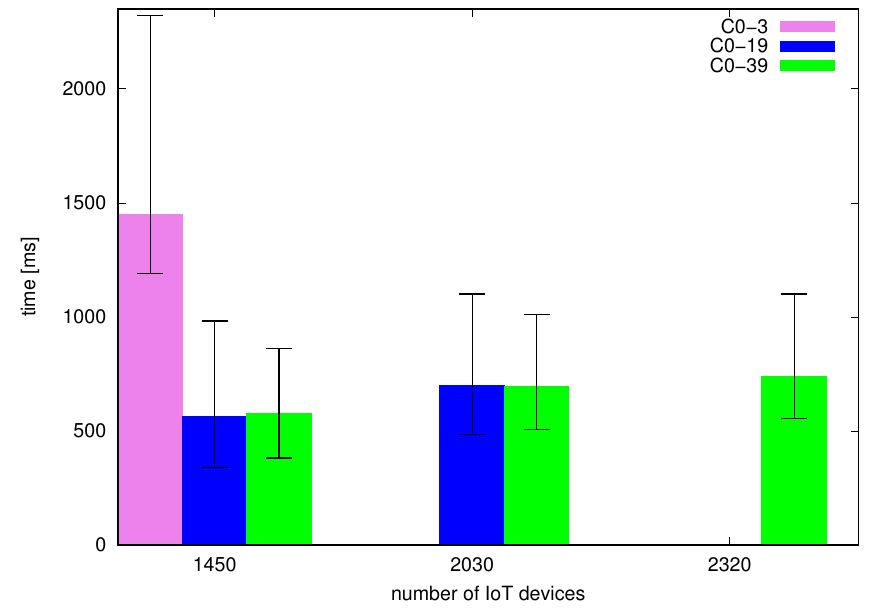
Figure 5. Processing time of request-response process from client side—container, bars denote medians and whiskers Q1 and Q3